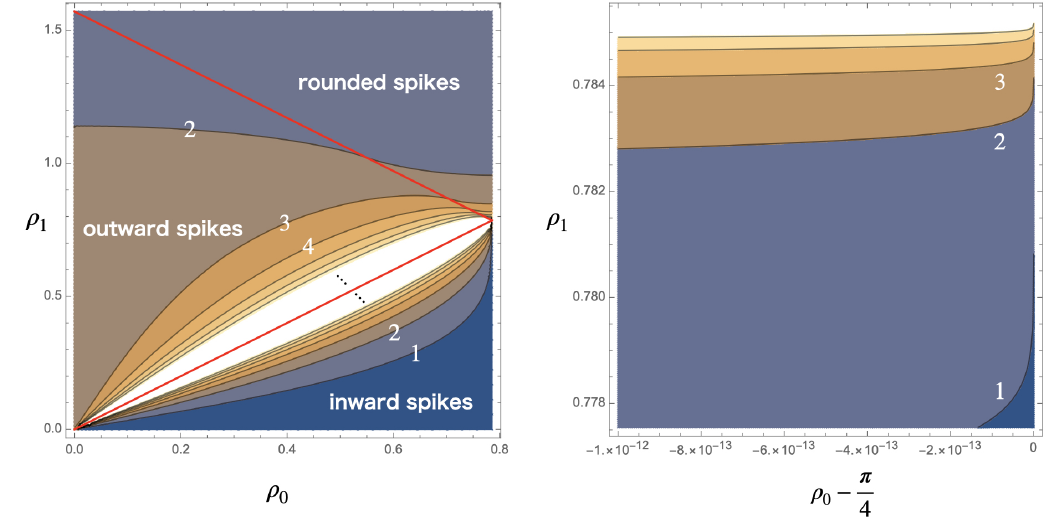
Figure 6 . Contour plot of 2 π/ ∆ φ as a function of ρ 0 and ρ 1 : an integer on each contour represents the value of 2 π/ ∆ φ for given ρ and ρ , which has to be n/N for n -spike strings with the winding 0 1 number N . The two red lines, ρ = ρ and ρ = π − ρ 0 , separate the ρ 0 - ρ 1 plane into three regions 1 0 1 2 which accommodate outward spikes, rounded spikes, and inward spikes, respectively. We find in particular that the string shape has a smooth transition from outward spikes to rounded spikes, as ρ 0 increases from 0 to π/ 4 for fixed n and N . Another important observation is that for inward spikes, ρ at ρ = π for a finite 2 π/ ∆ φ (see the right zoom-in figure around ( ρ π 1 < 0 4 4